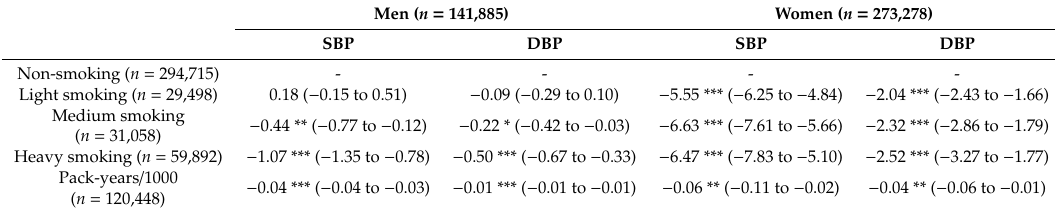
Table 3. Multivariable a linear regression coe ffi cients (95% confidence interval) for systolic and diastolic blood pressure levels according to smoking amounts